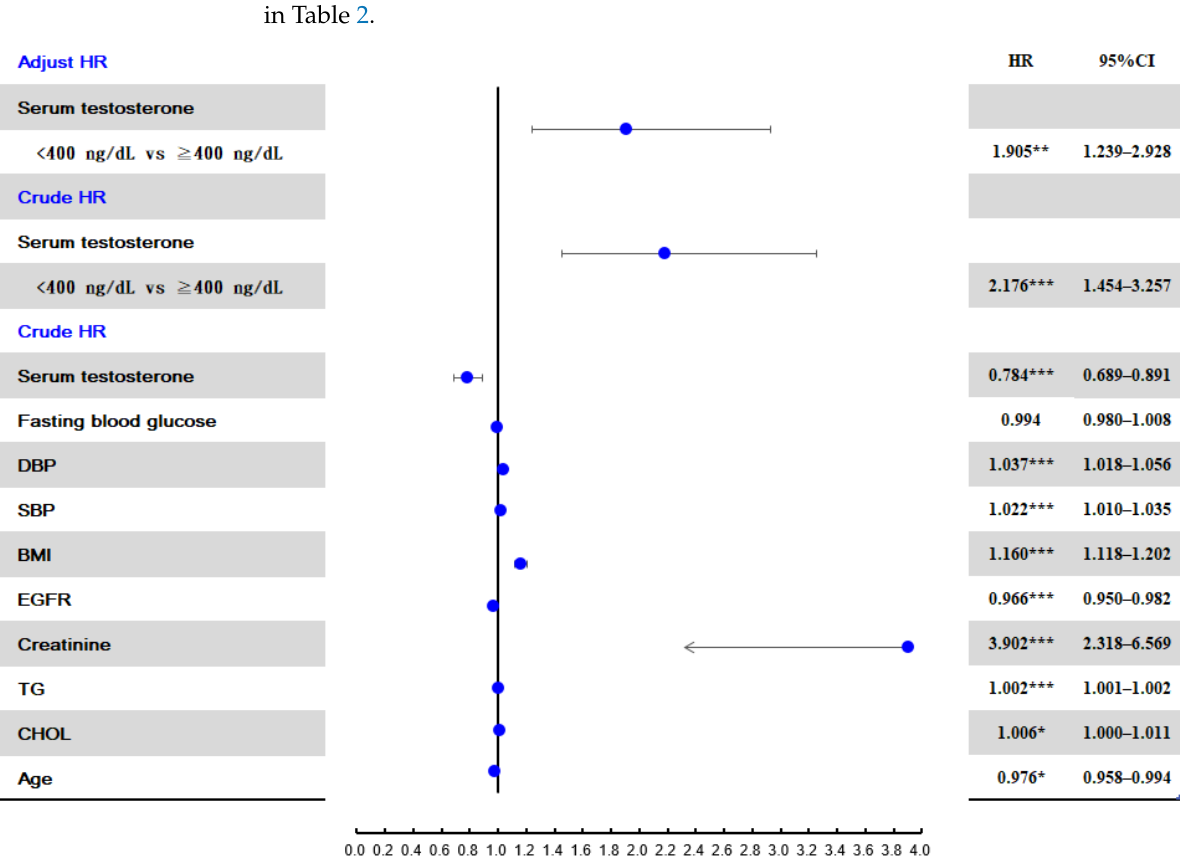
Figure 3. Risk factors for developing hyperuricemia (SU ≥ 9 mg/dL). * p < 0.05; ** p < 0.01; *** p < 0.001. Table 2. Risk of developing hyperuricemia according to the serum testosterone level and presence of